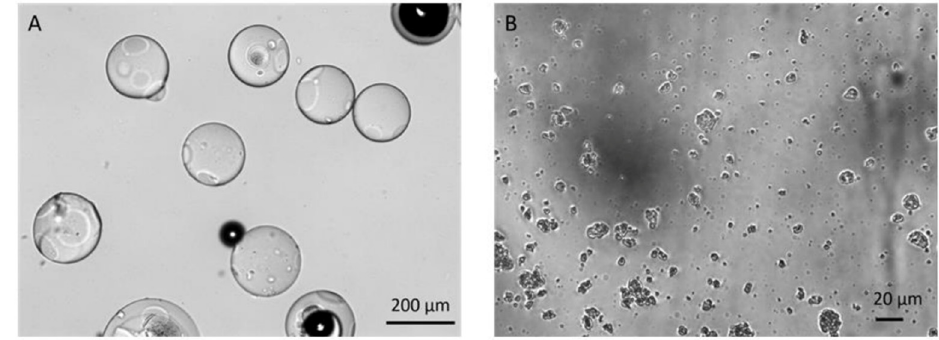
Figure 2. Light microscopy images of ( A ) β CDPB and ( B ) β CDPIS carriers in